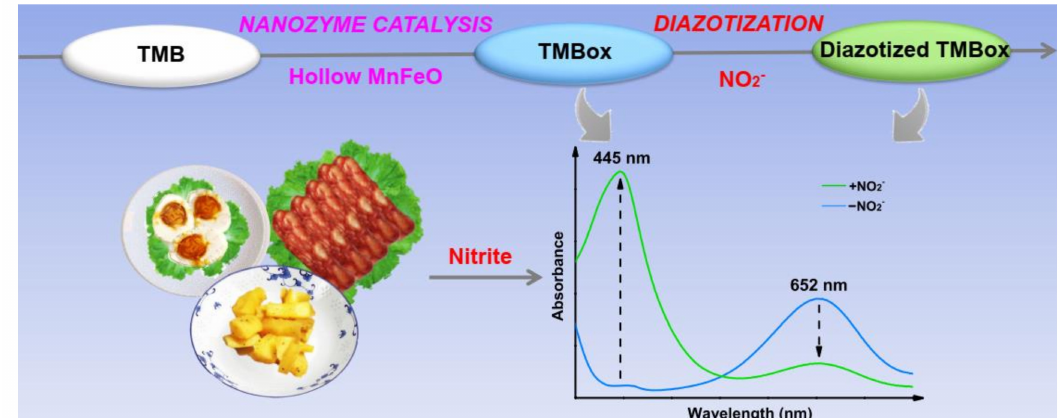
Scheme 1. Schematic illustration of the ratiometric colorimetric detection of nitrite in food based on the cascade reaction of nanozyme catalysis and